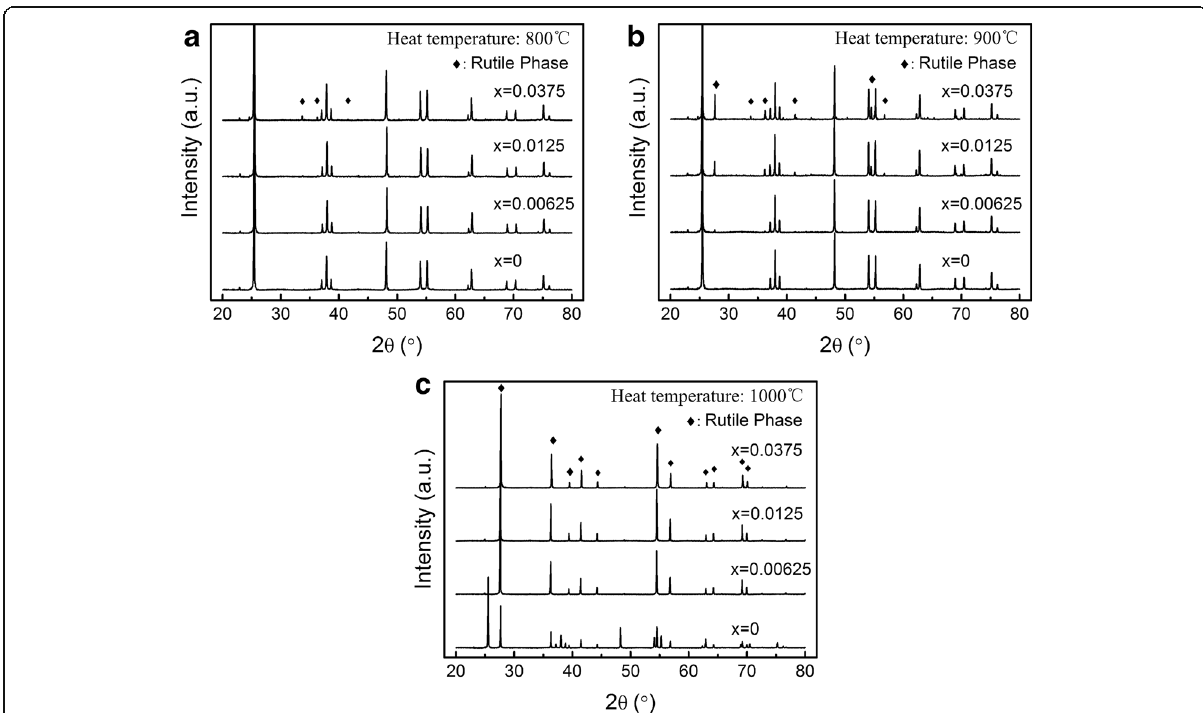
Fig. 1 a – c XRD patterns of Ti 1 − x Cr x O 2 products prepared at different sintering temperatures and doping concentrations (Sintering temperature is a : 800°C; b : 900°C; c :